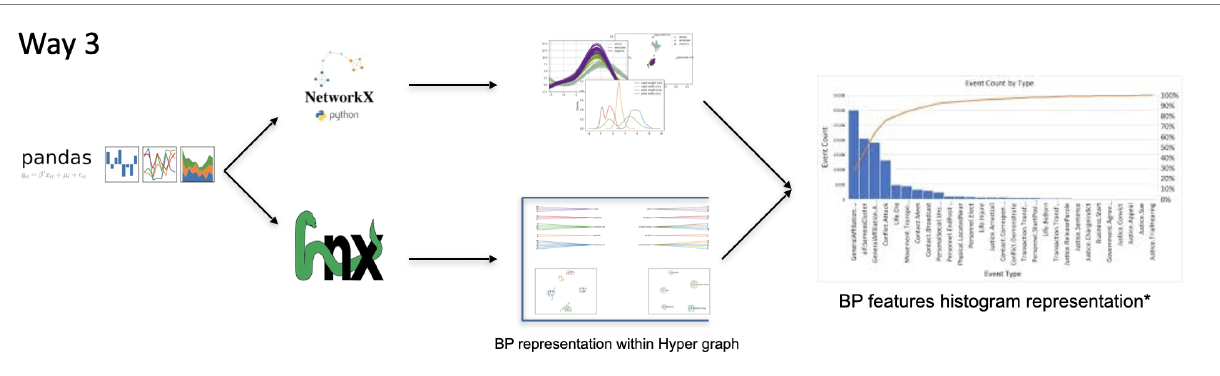
Figure 11. Third approach